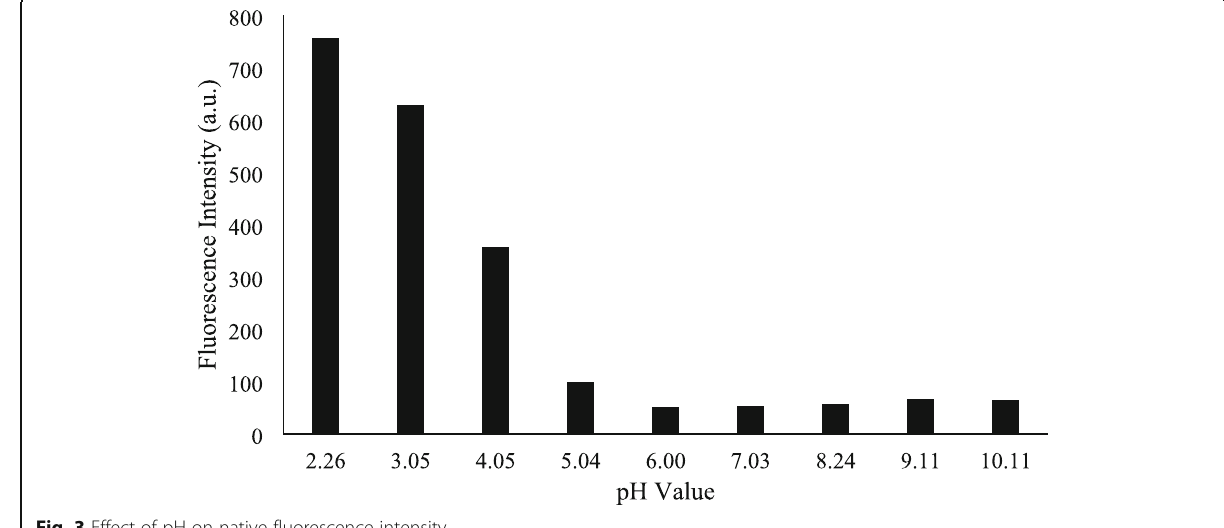
Fig. 3 Effect of pH on native fluorescence intensity